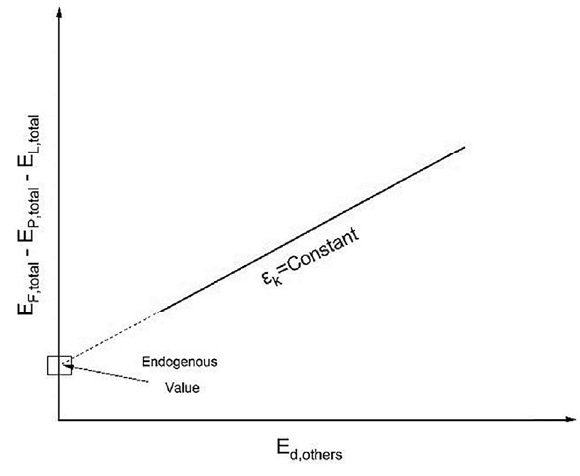
Figure 2. Value of exergy destroyed endogenously by the graphic method.